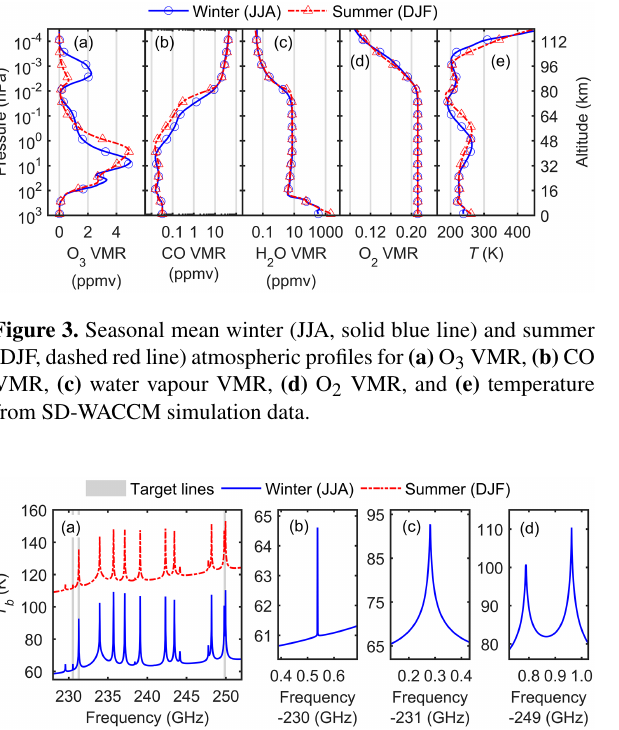
Figure 4. Simulated ground-based atmospheric brightness tempera- ture spectra for clear-sky conditions, 60 ◦ zenith angle viewing con- ditions at Halley station (75 ◦ 37 (cid:48) S, 26 ◦ 14 (cid:48) W), Antarctica for (a) the frequency range 228–252GHz in winter (JJA, solid blue line) and summer (DJF, dashed red line). The 300MHz wide target frequen- cies, highlighted as grey shaded panels in (a) , are shown enlarged for the (b) 230.54GHz CO, (c) 231.28GHz O 3 , and (d) 249.79 and 249.96GHz O 3 lines in